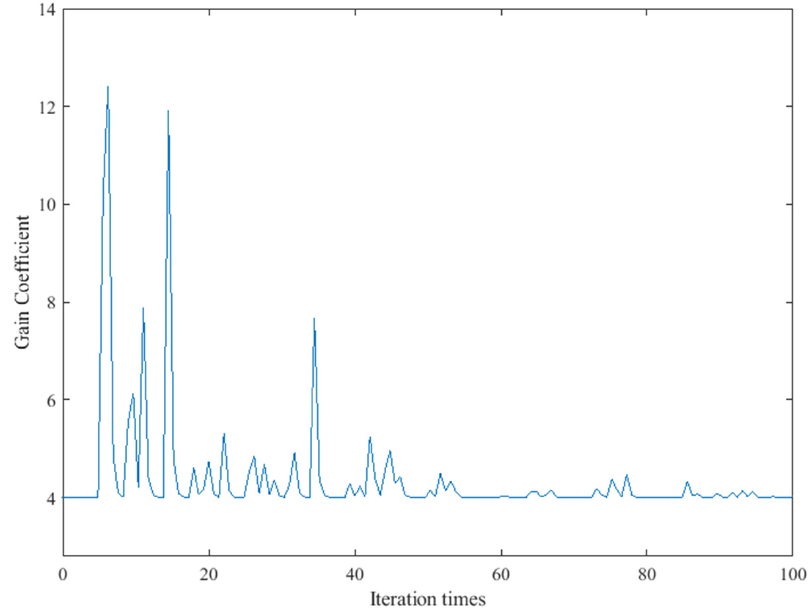
Figure 10. Curve of the update gain coefficient of the SPGD algorithm applied to the LSCM system.